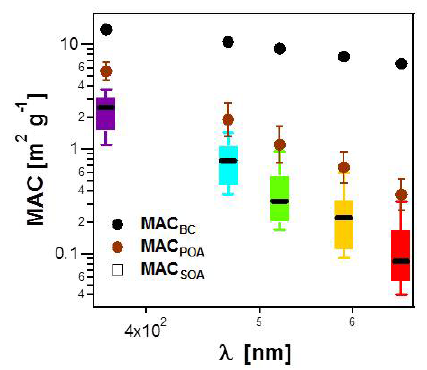
Figure 4. MAC SOA (λ) calculated from several smog chamber ex- periments plotted as boxes and whiskers as a function of wave- length (also shown by the color of the bars). The thick black lines, the boxes and the whiskers mark the medians, the quartiles and the 10th and the 90th percentiles, respectively. Also shown are the MAC BC (λ) and MAC POA (λ) reported in Table 1. Note that MAC SOA (880nm) and MAC POA (880nm) are zero by